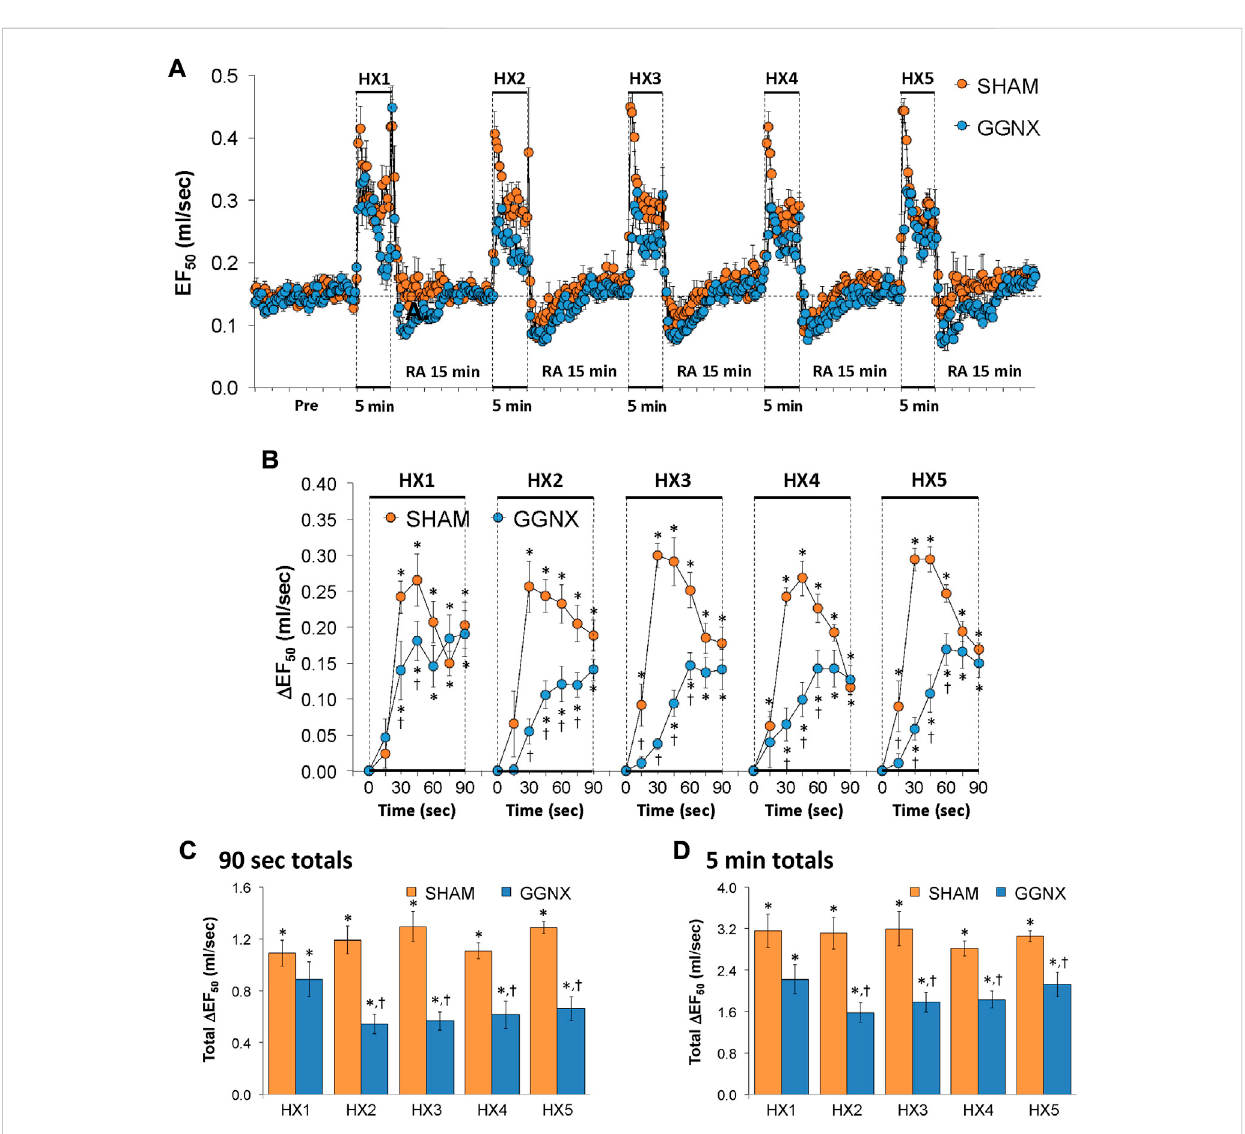
FIGURE 11 (A) EF 50 values in sham-operated (SHAM) rats and in rats with bilateral ganglioglomerular nerve transection (GGNX) before (Pre) and during fi ve hypoxic (HX, 10%